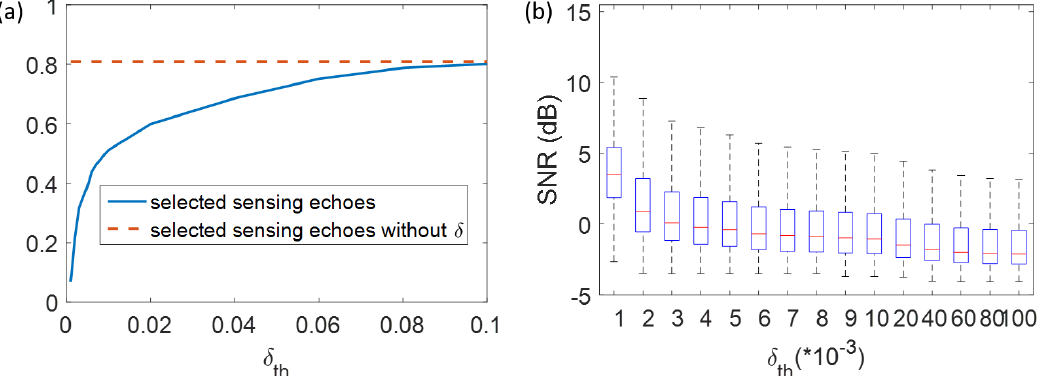
Figure 7. Analysis of confidence factor threshold δ th : ( a ) selected ratio of sensing echoes (where the dotted line indicates the proportion of selected sensing echoes only regardless of the confidence factor δ ); and ( b ) SNR distribution of the selected sensing